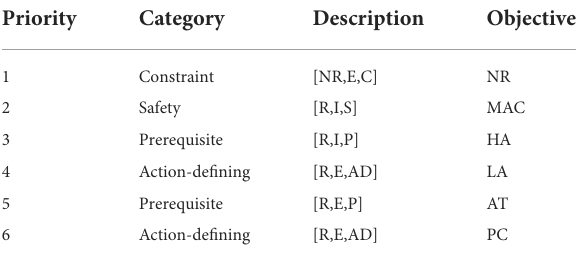
TABLE 4 Examples of external activation states for different tasks. Priority Tasks Way point Alignment Landing Tool